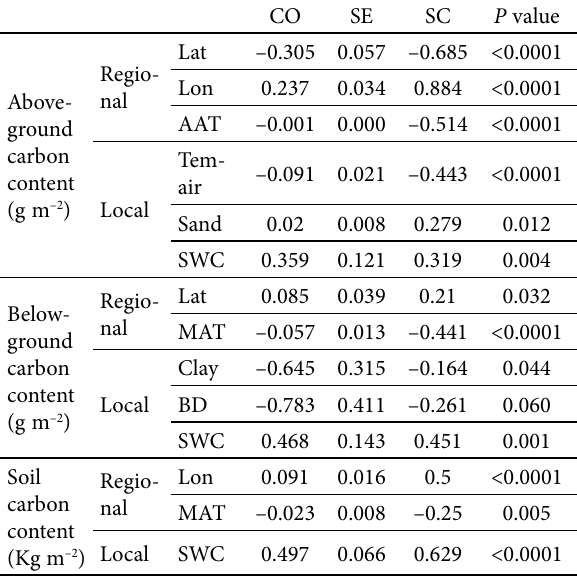
Table 2. Summary of the results obtained from multiple linear regressions, showing the effects of regional and local factors on three carbon pools in alpine grassland of Tibetan Plateau CO SE SC